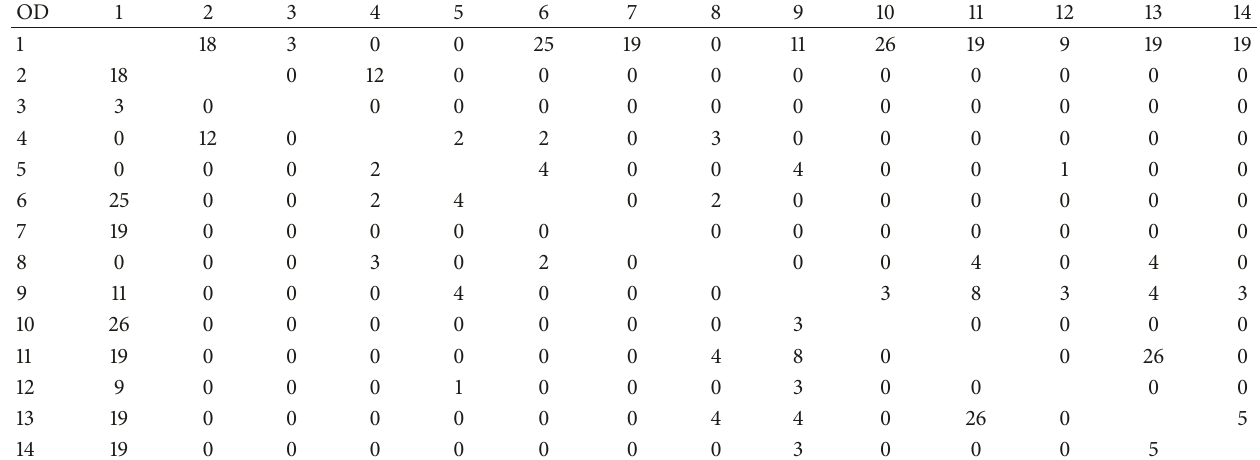
Table 2: Passenger transport shift numbers between OD pairs (times).